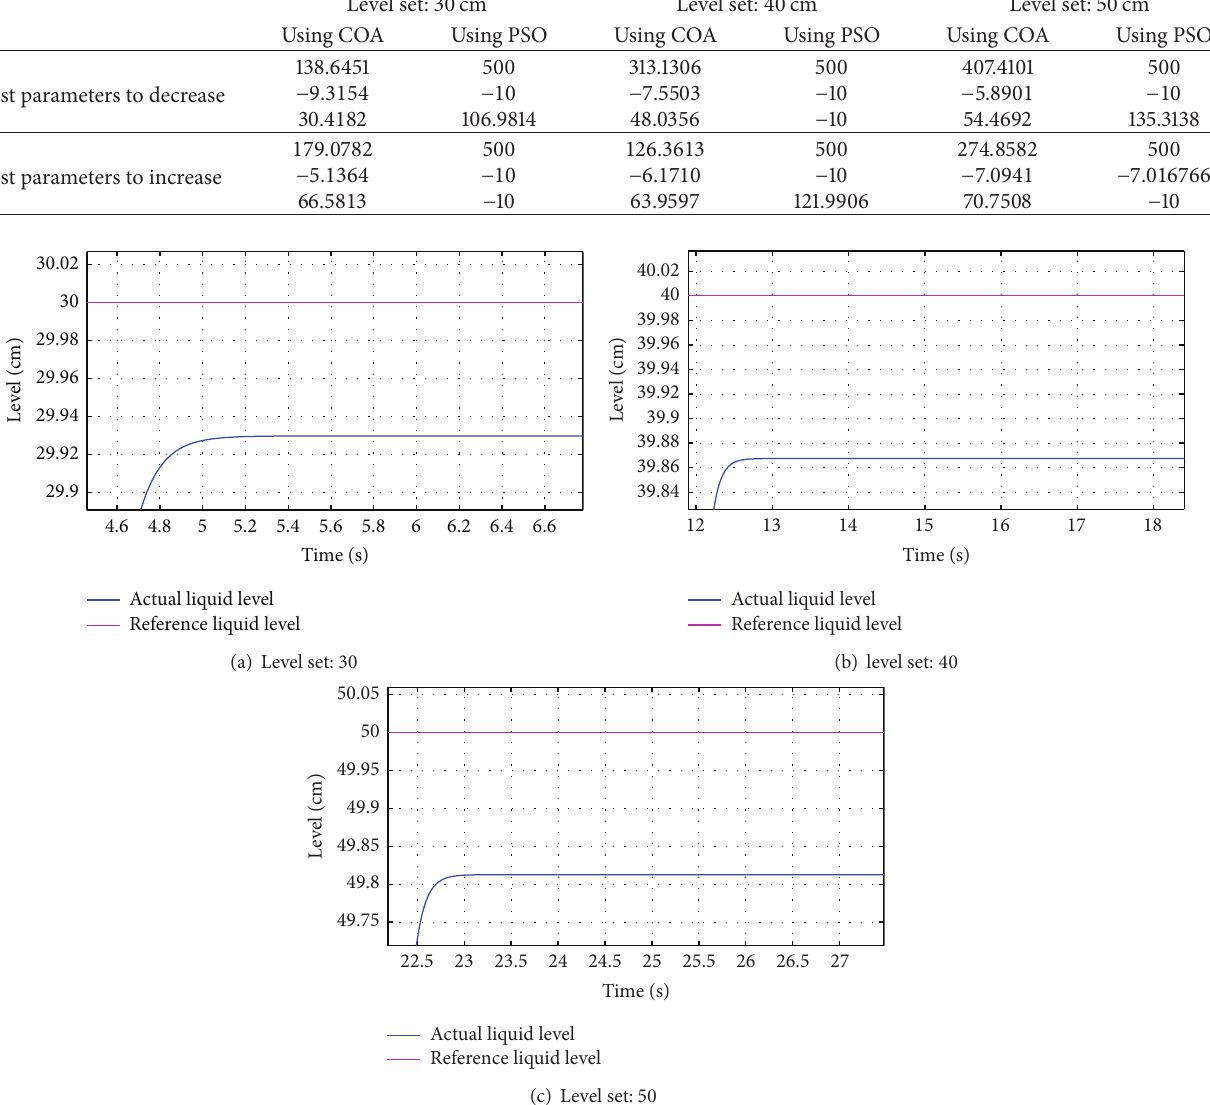
Figure 8: Response of the manually tuning controller parameter.